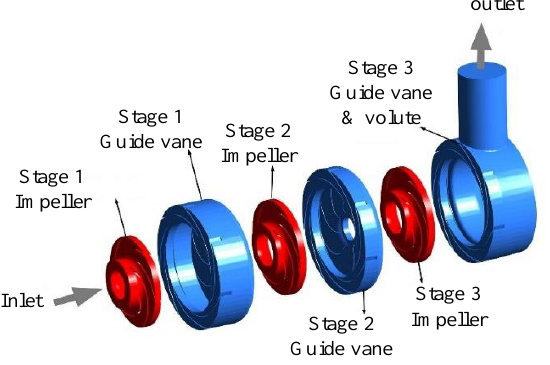
Figure 2. Exploded view of the research